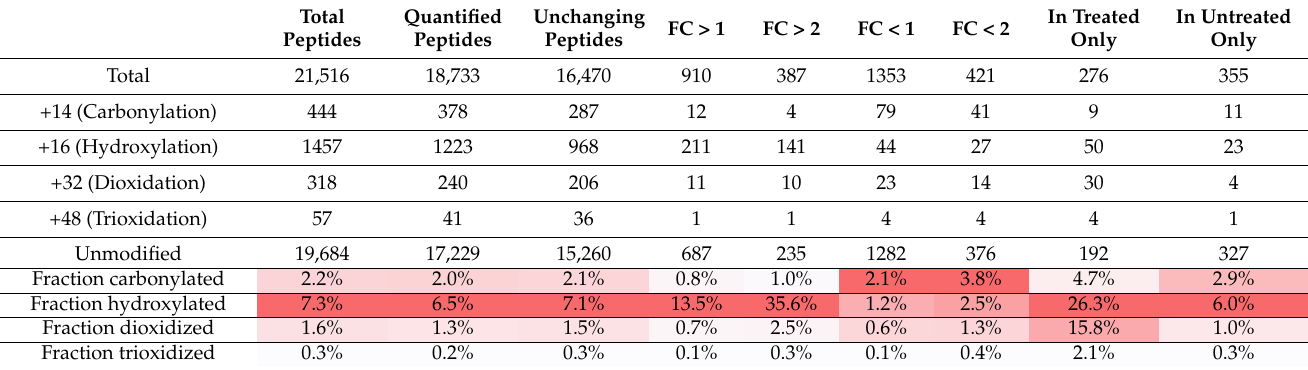
Table 1. Observed peptide oxidation for MG1655 (3 kGy:0 Gy) bacterial strain. Total